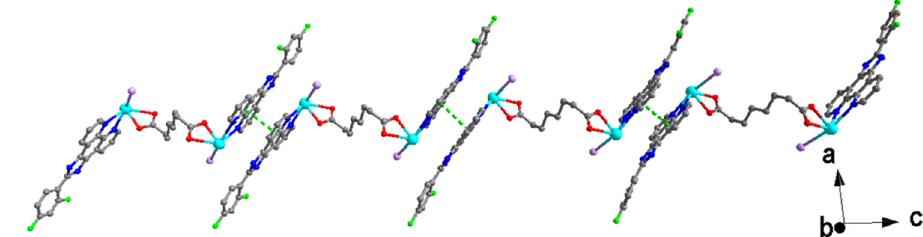
Figure 4: View of the 1D chain structure of 1 constructed by π – π interactions.